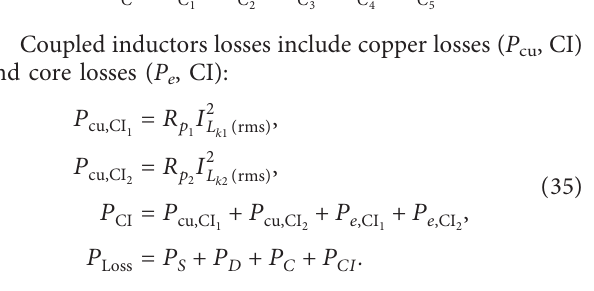
Figure 12: Core simulation with duty cycle D � 0.5.